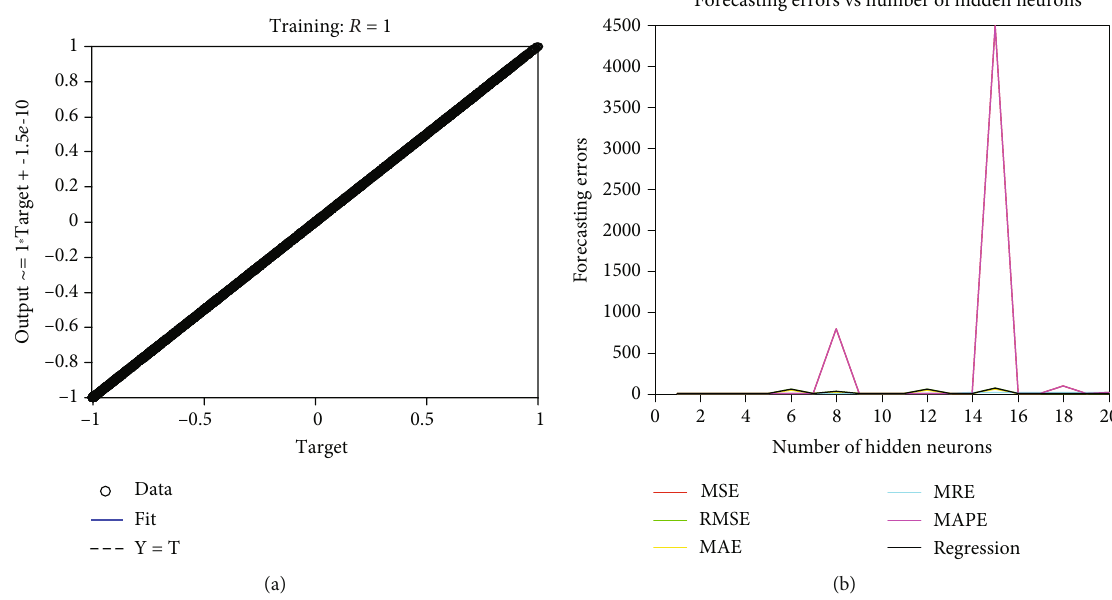
Figure 18: (a) Six input MLPNN-based forecasting model regression graphs. (b) Six input MLPNN-based forecasting model forecasting errors vs. the number of hidden neurons.